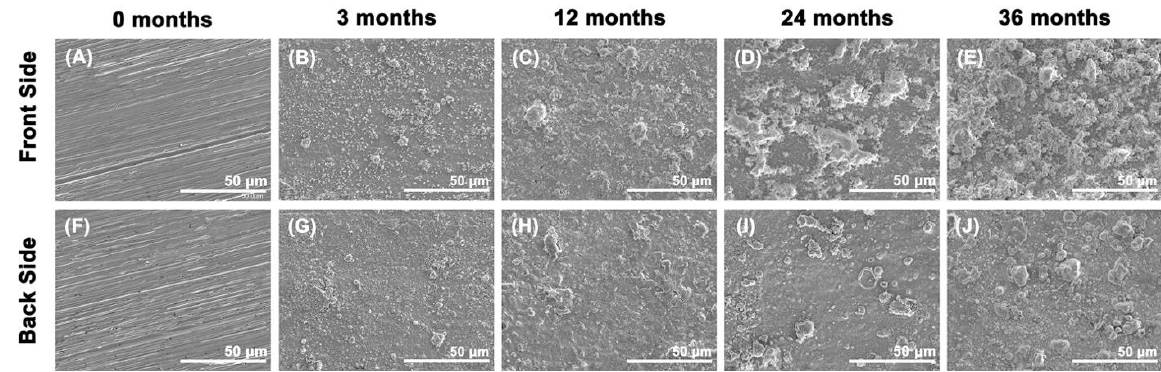
Figure 8. SEM of copper after 0 ( A , F ), 3 ( B , G ), 12 ( C , H ), 24 ( D , I ), and 36 ( E , J ) months of exposure, magnification 1000 × . Table 2. EDS of the copper corrosion product at different exposure times.